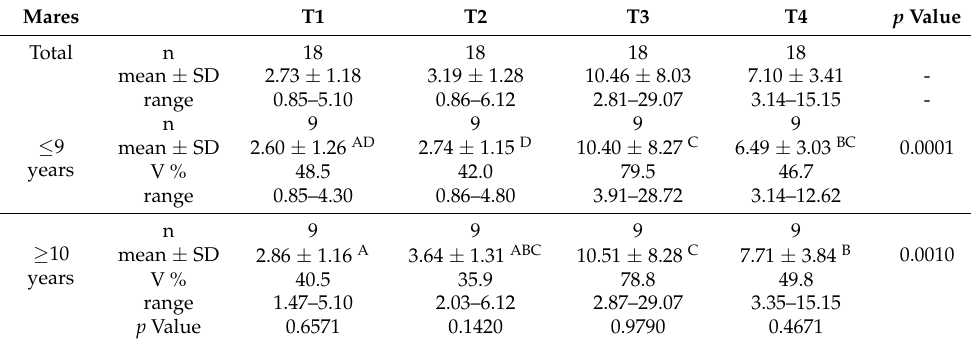
Table 1. Cortisol level relative to mares’ age